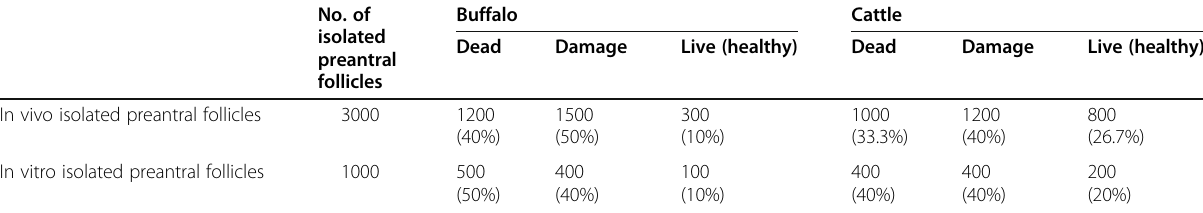
Table 2 The percentage of viability of preantral follicles